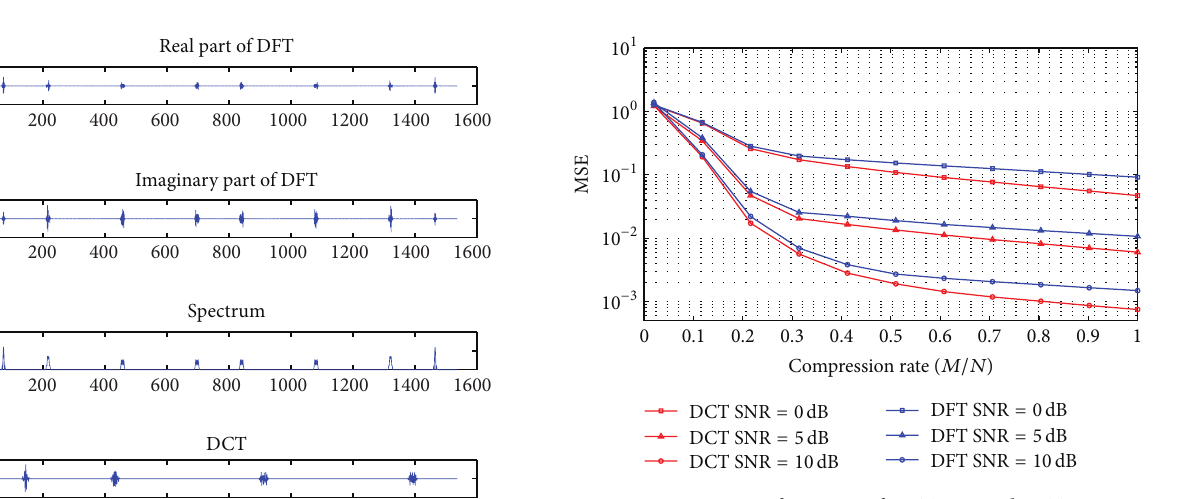
Figure 4: MSE performance of DCT-CSS and